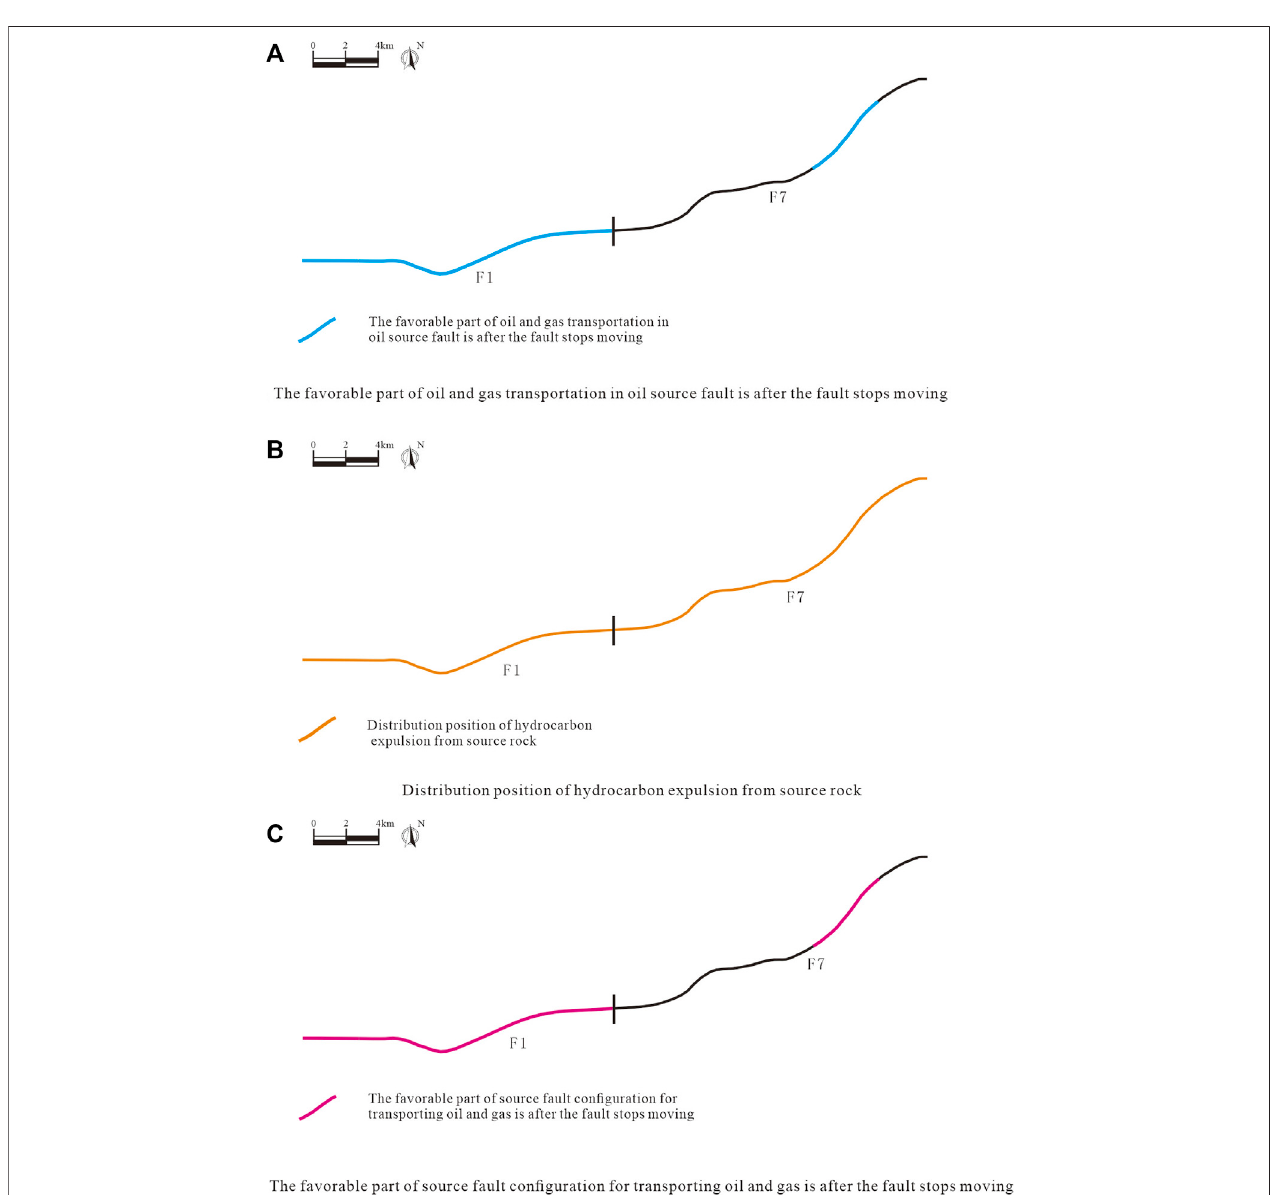
FIGURE 10 | The map of the favorable position of the source and fault con fi guration for transporting oil and gas in the southwest of the Jiuzhou fault after the fault ceases to be active in the middle and lower sub-member of Es3.